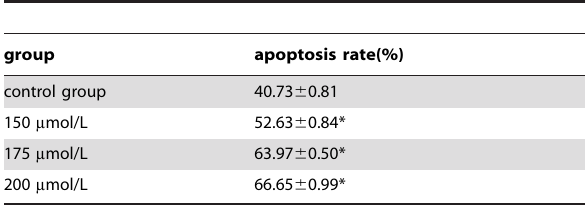
Table 4. Effect of different concentrations of Artesunate on HSCs apoptosis ( x 6 s, n